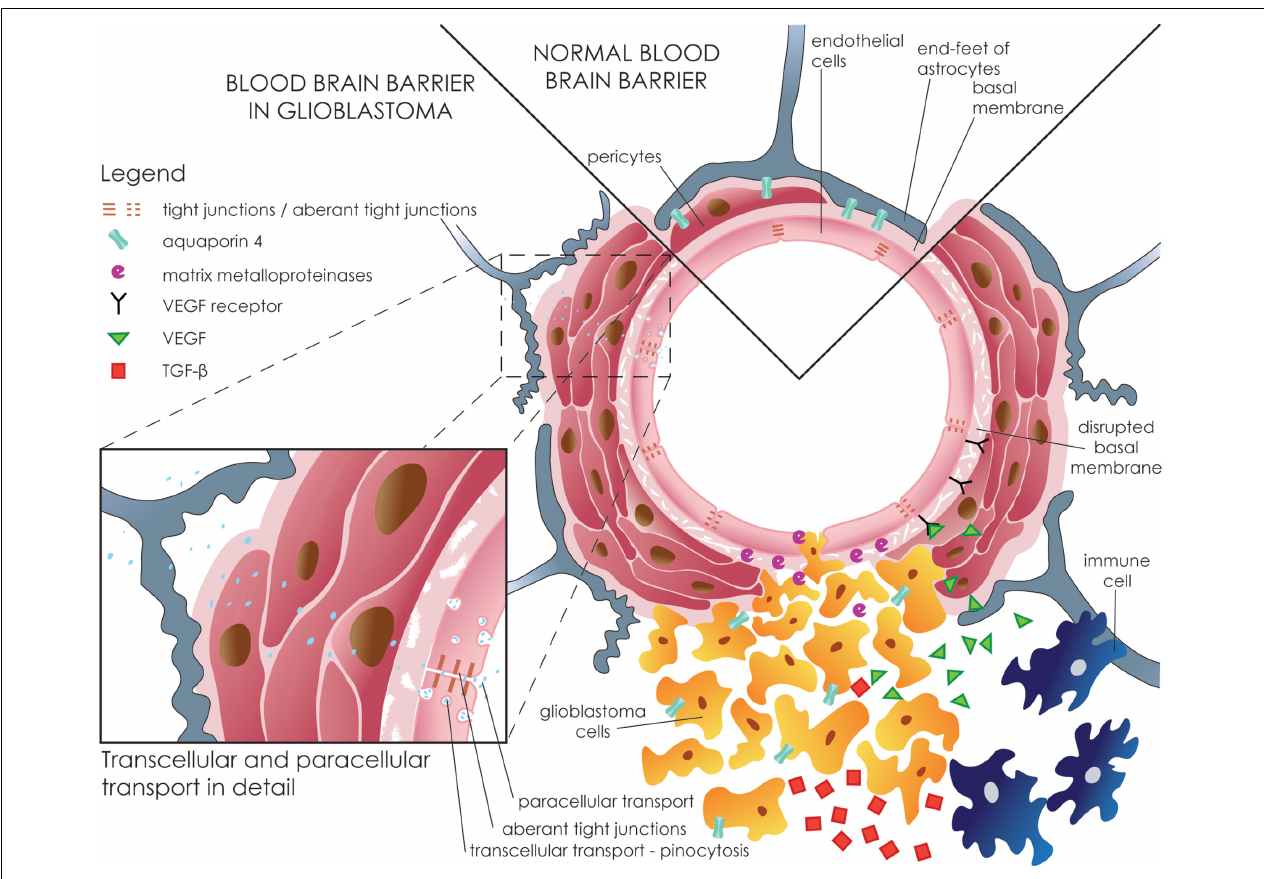
FIGURE 3 | Disruption of the blood-brain barrier in glioblastoma. GBM cells infiltrate the perivascular space with subsequent astrocytic end-feet displacement. Tumor, stromal, and immune cells occupy a specific tumor niche with a diverse proteomic profile but most importantly show upregulated VEGF and TGF-ß. VEGF binds to its receptor on endothelial cells leading to increased transendothelial permeability and downregulation of specific TJs (e.g., claudin-5, occludin, and ZO-1) and subsequent increased paracellular influx. Matrix metalloproteinases, most importantly MMP-9, that are secreted by tumor cells contribute to the disruption of the basal membrane by cleaving the ECM. Inset shows a more detailed view of the transcellular and paracellular movements across the BBB. The endothelium forms the inner layer of the BBB. GBM promotes a “leaky” phenotype in endothelial cells with increased transcellular transport and endothelial fenestrations. Additionally, down-regulation of TJs leads to increased paracellular transport with subsequent edema